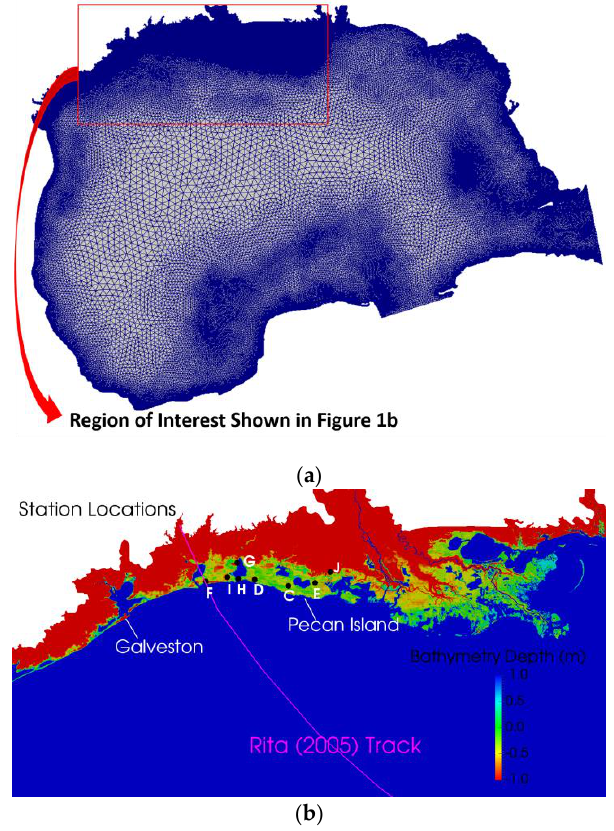
Figure 1. Unstructured ULtralite-Levee-Removed (ULLR) [1] mesh ( a ) resolution; ( b ) observation station locations with respect to Hurricane Rita track. Note that the bathymetry is manually set between 1 m and − 1 m to show the shoreline. Here a negative bathymetry represents above sea